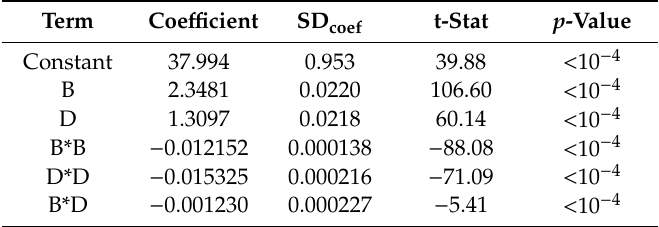
Table5. EstimatedregressioncoefficientsofextractionofCd(II)usingMinitabsoftware;B: Aliquat 336 (mM); D: EDTA